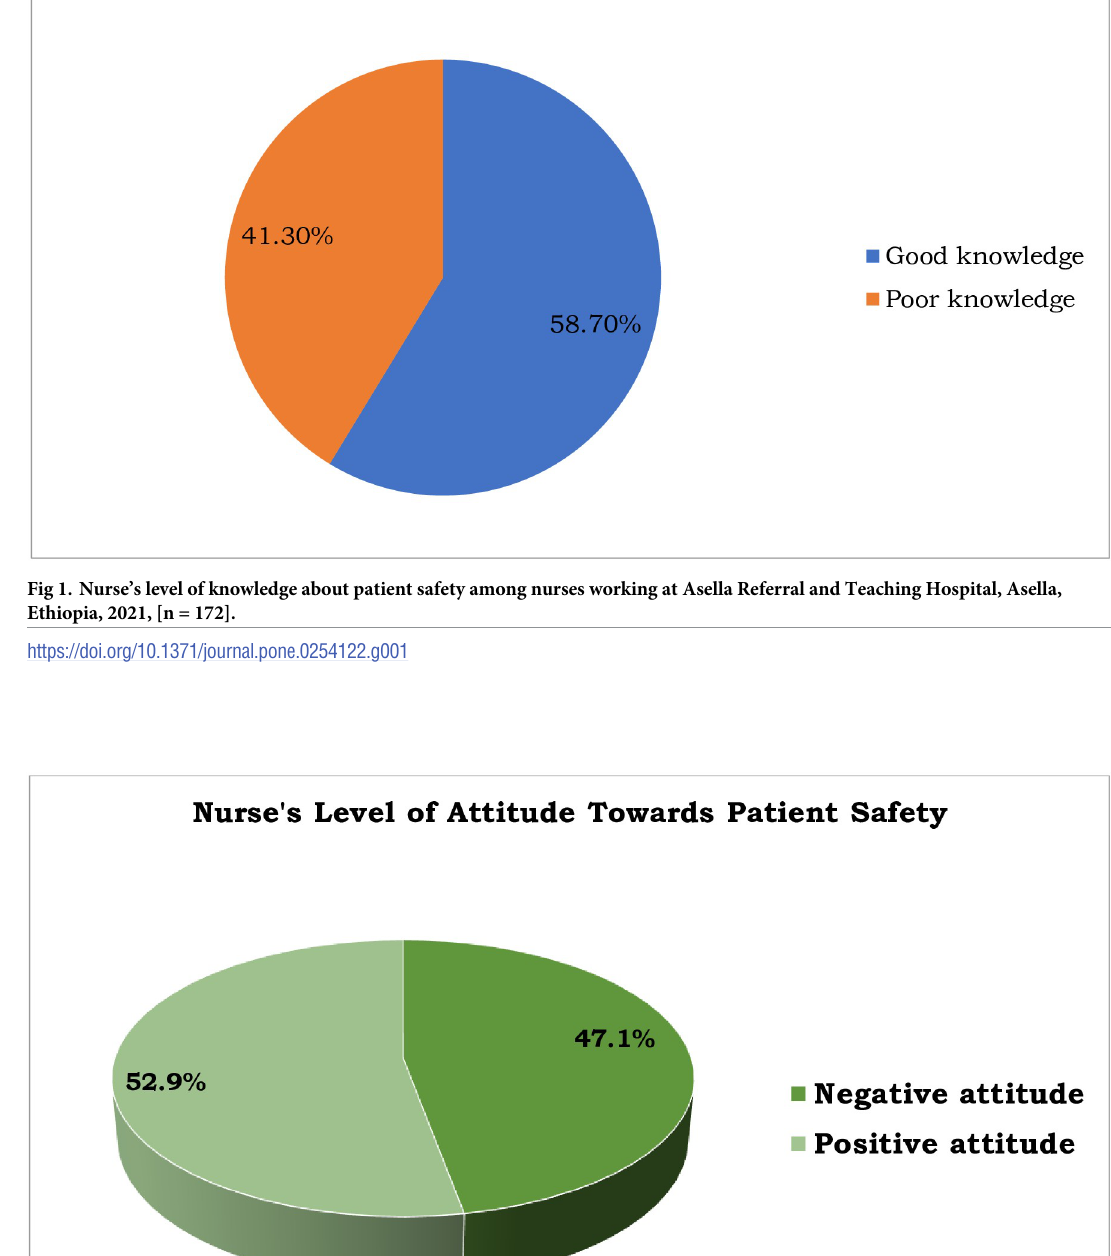
PLOS ONE | https://doi.org/10.1371/journal.pone.0254122 July 1, 2021 9 /